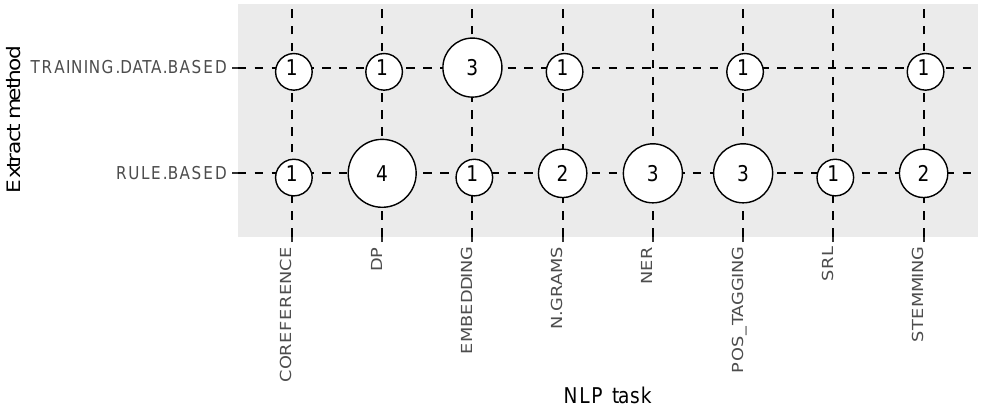
Figure 11. Mapping the NLP task and each extraction approach applied in Open IE studies—for the x -axis, the NLP tagger; for the y -axis, the extraction approach. (Authors’ own).